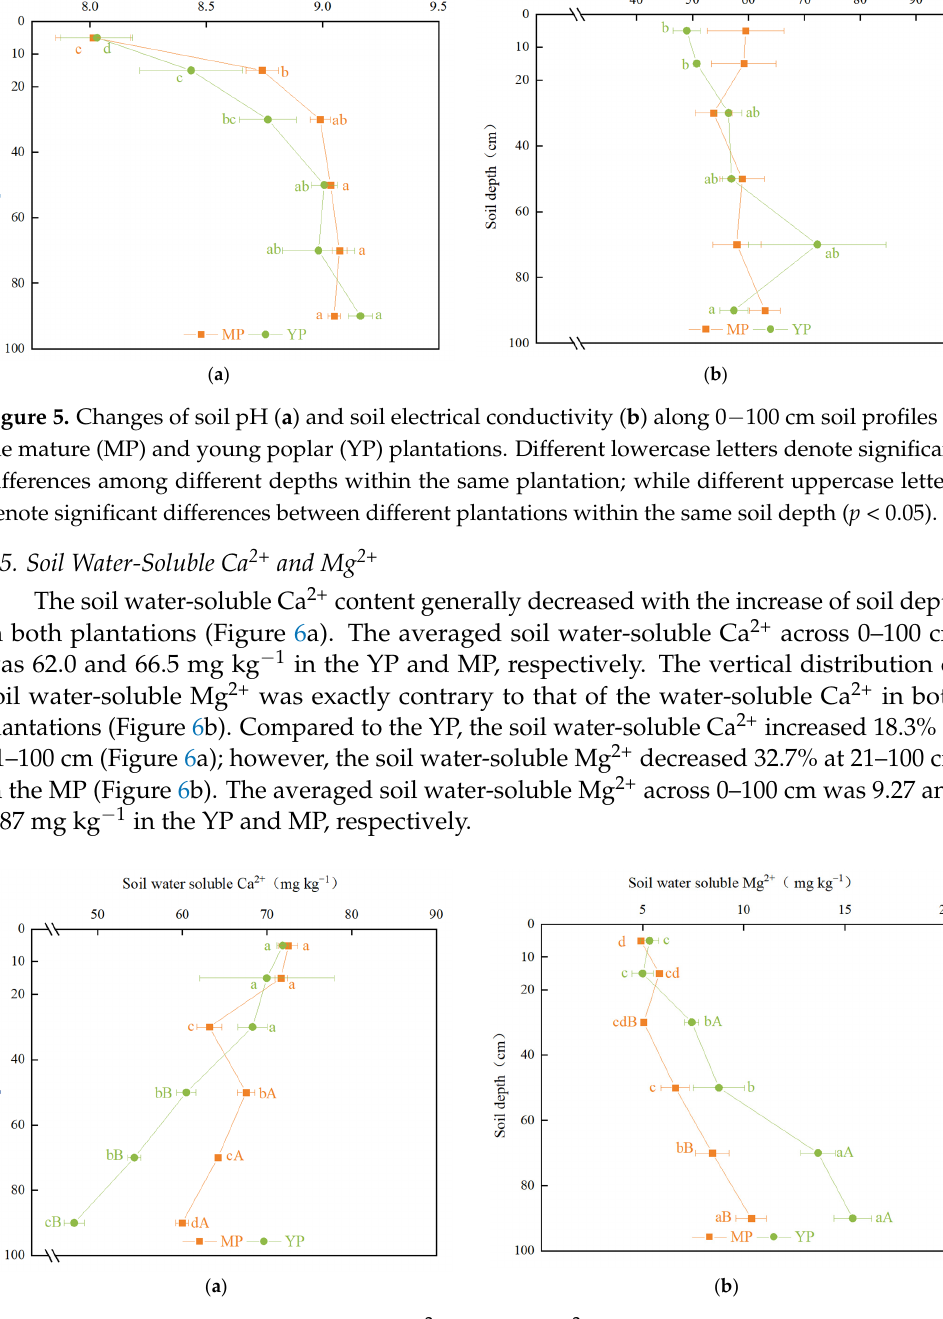
Figure 4. Changes of soil organic carbon along 0 − 100 cm soil profiles in the mature (MP) and young poplar (YP) plantations. Different lowercase letters denote significant differences among different depths within the same plantation; while different uppercase letters denote significant differences between different plantations within the same soil depth ( p < 0.05).